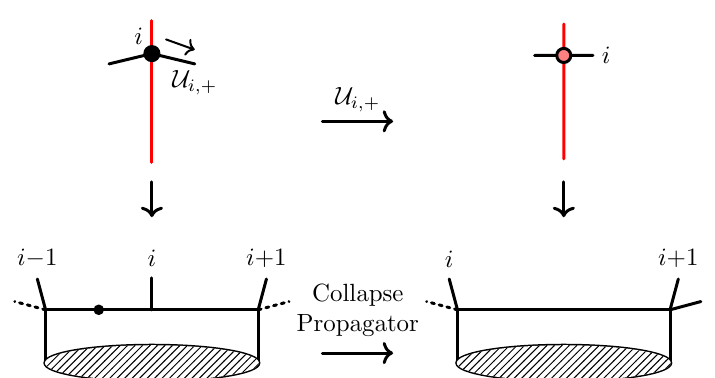
Figure 5. The graph operation U i; + relaxes a line L constrained to pass through the point i , shifting it to lie only along the line ( i i +1). This is equivalent to removing the on-shell constraint hL i (cid:0) 1 i i = 0. (The equally valid relaxation U i; (cid:0) , not pictured here, lets the intersection point slide onto ( i (cid:0) 1 i ).) On Landau diagrams, this corresponds to collapsing the propagator indicated by the (cid:12)lled dot in the bottom (cid:12)gure on the left. The shaded region in the (cid:12)gures represents an arbitrary planar sub-graph. A dashed external line on a Landau diagram may be either one massless external leg so the whole corner is massive, or completely removed so the whole corner is massless. As explained in the caption of (cid:12)gure 4, the U operation can be thought of as a special case of the R operation, and we distinguish the two because only the latter can change the helicity sector